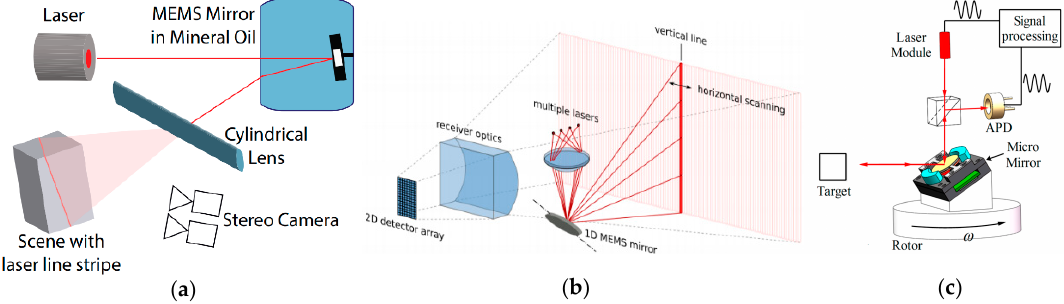
Figure 4. ( a ) The structured light camera design uses an 1D MEMS mirror and di ff used laser [52]; ( b ) The LiDAR designed by Infineon uses a 1D MEMS mirror and a lasers array [54]; ( c ) The LiDAR with an 1D MEMS mirror and a motor for 2D scanning [56].